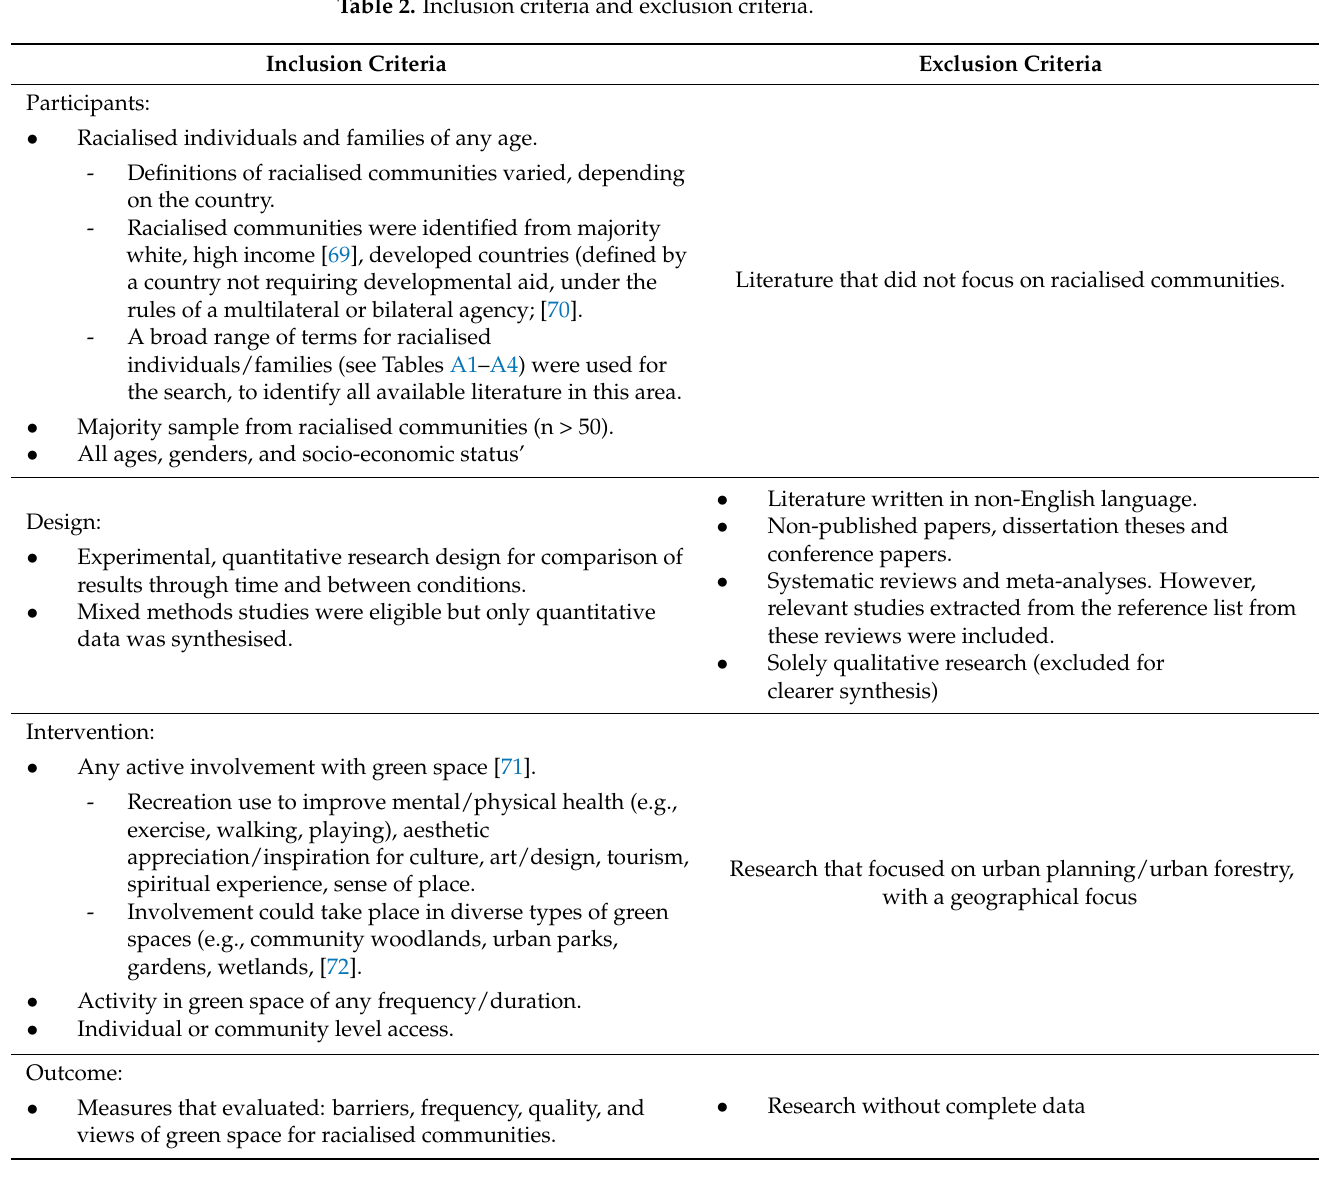
Table 2. Inclusion criteria and exclusion